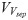
Validation on lung images.(A) Illustration of a lung slide with sampling strategy. (B-C) Macro results for VVsep * and Lm† plotted against the manual values. The regression line is plotted in red, dashed line represents identity (y = x). (D-E) Bland-Altman plots for VVsep * and Lm† plot the relative difference [(manual–macro)/average] to the average result. Red line indicates bias, with confidence interval (dashed red line). *volume density of alveolar septa (VVsep); †mean linear intercept of the airspaces (Lm).